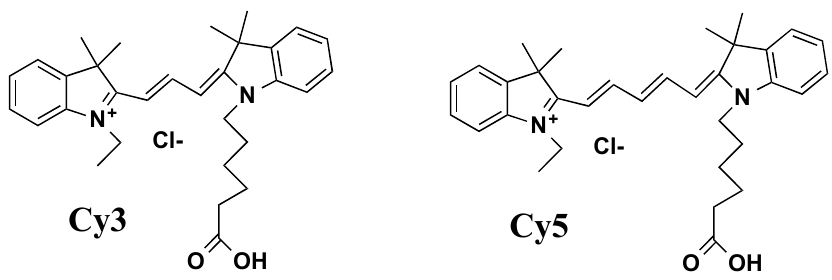
Figure 8. Cyanine fluorophores Cy3 and Cy5.